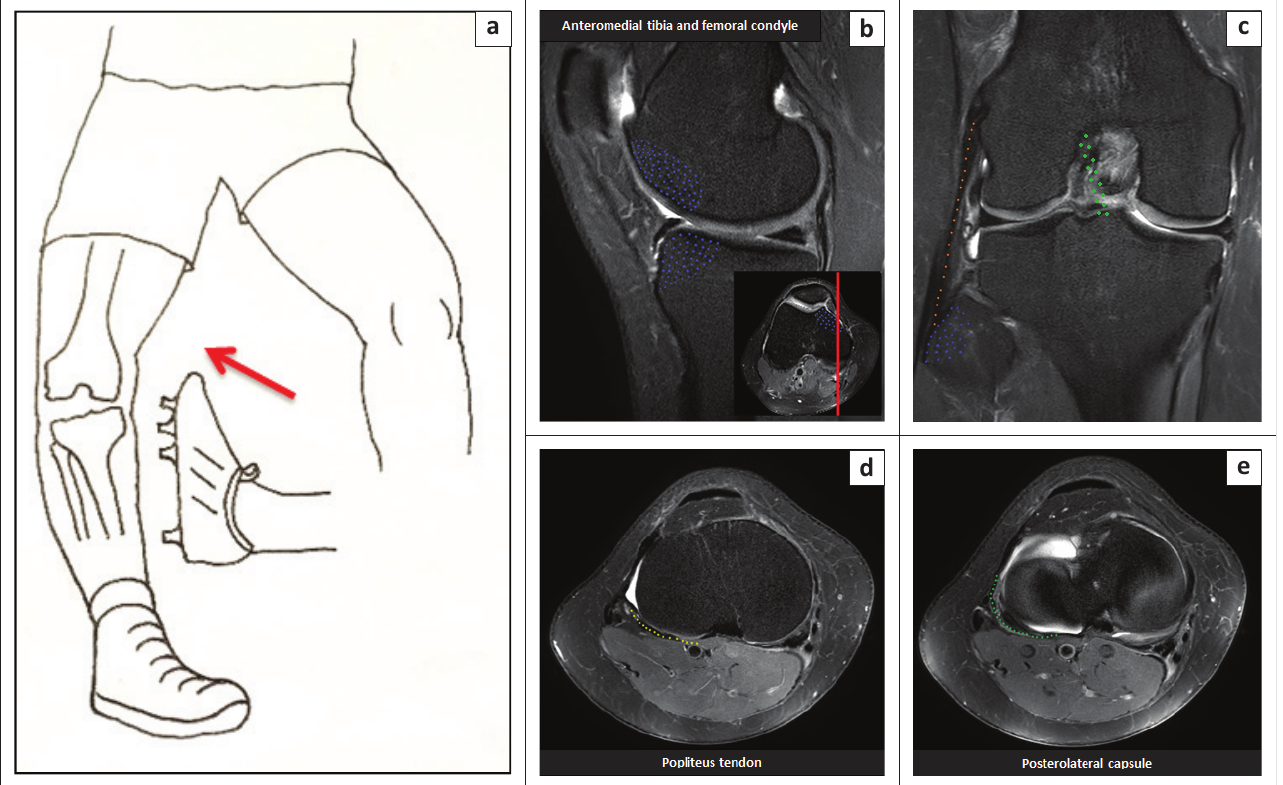
FIGURE 2: Hyperextension with varus: (a) Schematic depicts anteromedial impact with posterolateral force, (b) right knee anteromedial tibia and femoral condyle impactions, (c) lateral collateral ligament injury with proximal fibula avulsion oedema, and possible anterior cruciate ligament injury, and (d) and (e) show posterolateral corner disruption which may include popliteus and posterolateral capsule